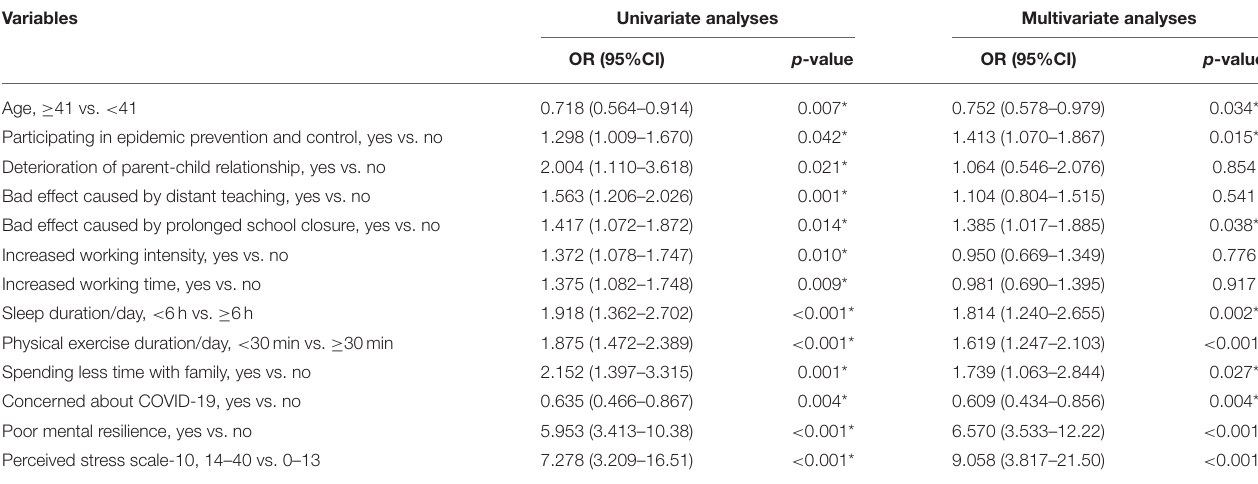
TABLE 2 | Univariate and multivariate logistical regression analyses of correlates of depression. Variables Univariate